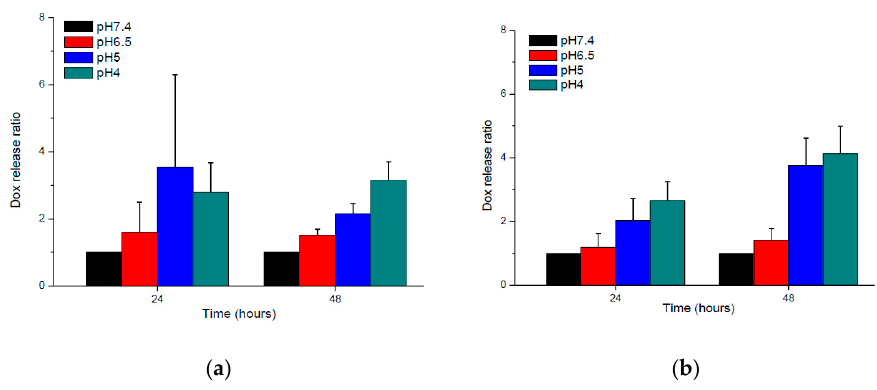
Figure 8. DOX release ratio of ( a ) BD5 and ( b ) HBD5 polymeric nanoparticles at different pH.